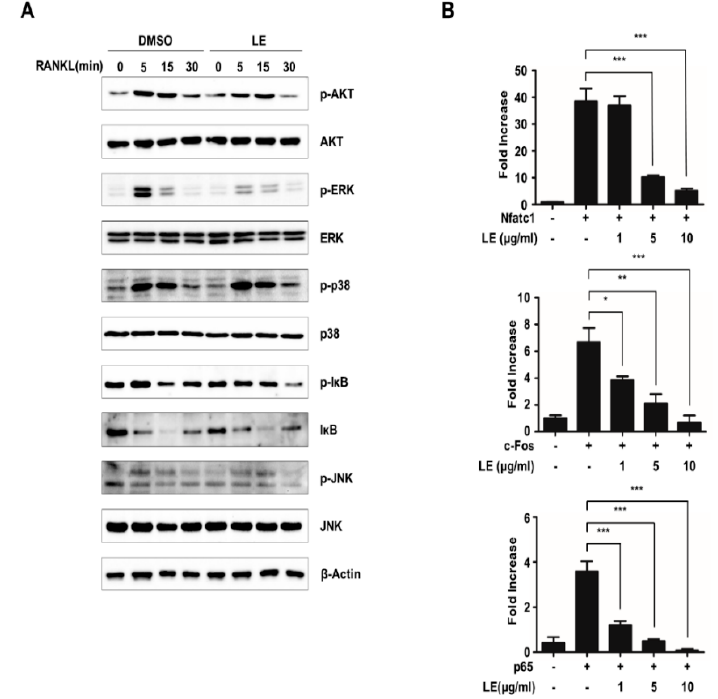
Figure 4. Leaf extract of Abeliophyllum distichum suppresses NFATc1 expression by blocking NFATc1, p65 and c-FOS-mediated transactivity. ( A ) BMMs were pre-treated with DMSO and LE (10 µ g / mL) for 2 h, and stimulated with RANKL for 0, 5, 15, and 30 min. The cells were lysed and immunoblotted with antibodies against p-AKT, AKT, p-ERK, ERK, p-I κ B, I κ B, p-p38, p38, p-JNK, and JNK. ( B ) 293T cells were transiently transfected with the reporter plasmid Nfatc1-Luc along with c-Fos , p65 , or Nfatc1 in the presence or absence of LE. Luciferase activity was measured after 24h post-transfection. Each bar represents the mean ± SD of three independent experiments. * p < 0.05, ** p < 0.01, *** p <